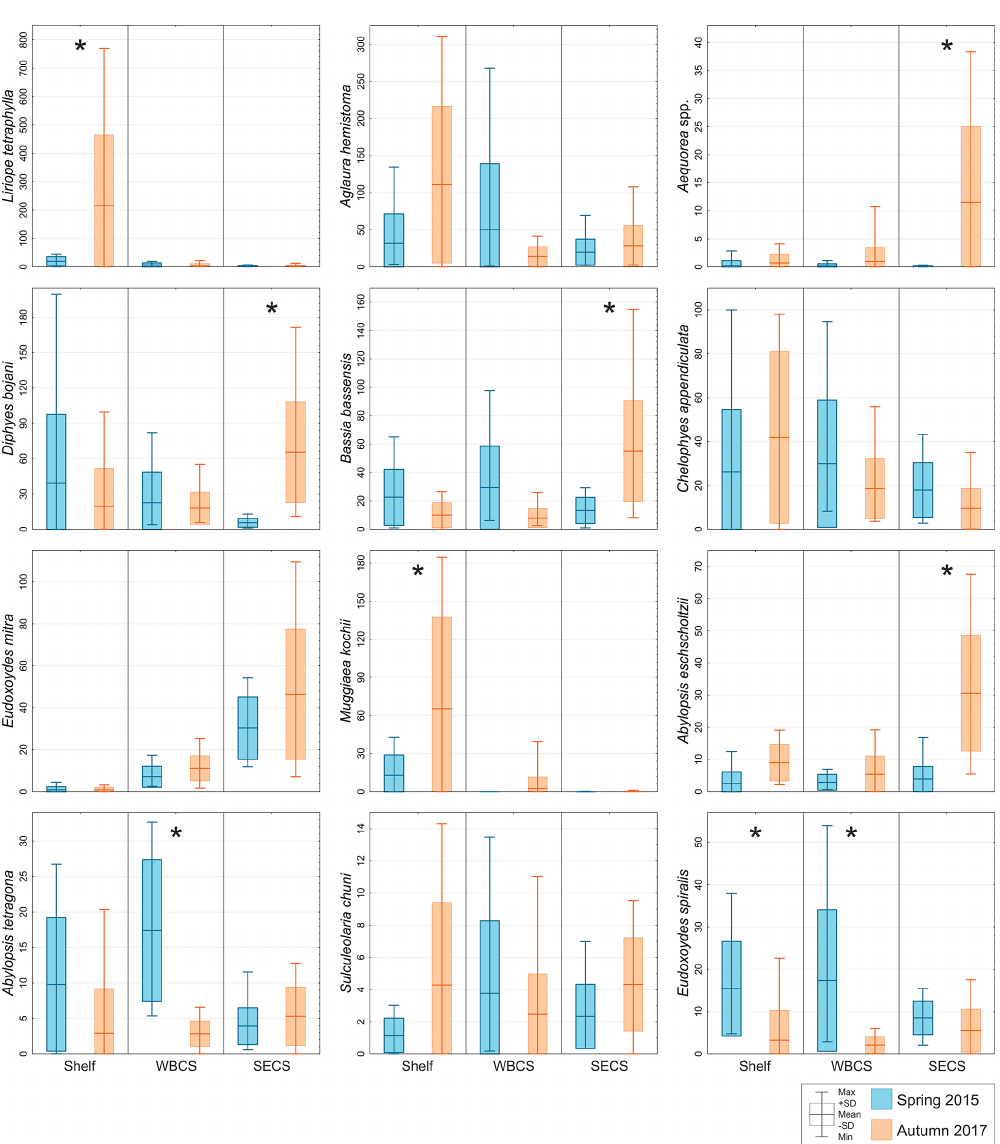
Figure 5. Comparison of average abundance (ind. 100m − 3 ) of representative species of hydromedusae and siphonophores during spring 2015 (blue) and autumn 2017 (orange) in three distinct areas from the western tropical South Atlantic. ∗ Significant seasonal changes in